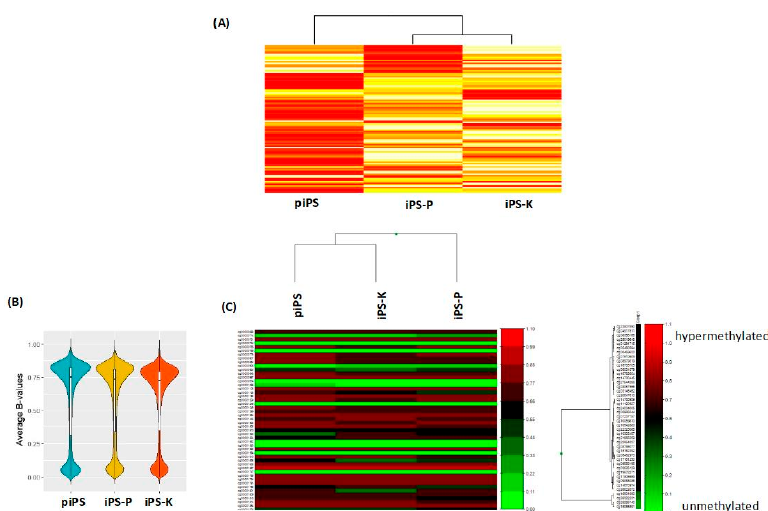
Figure 2. Analysis of transcription and methylation profile of iPS cells of different origin ( A ) Heatmap for mRNA expression microarray data after filtering and NEQC (normexp background correction and quantile normalization) normalization for 3 samples of iPS cells (piPS, iPS-K, iPS-P). Yellow color indicates genes displaying lower expression and red refers to genes with higher expression. ( B ) Violin plot showing the distribution of average methylation β -value for 3 samples (piPS, iPS-K, iPS-P). ( C ) Manhattan and correlation models were used to generate sample clustered heatmap of iPS cell lines (piPS, iPS-K, iPS-P) after methylation analysis. For cluster analysis, the most variable CpG probes were selected based on the s.d. of the β -values. The heatmap scale is from 0 to 1, where the green color indicates unmethylated sites and red refers to hypermethylated sites ( β -value =